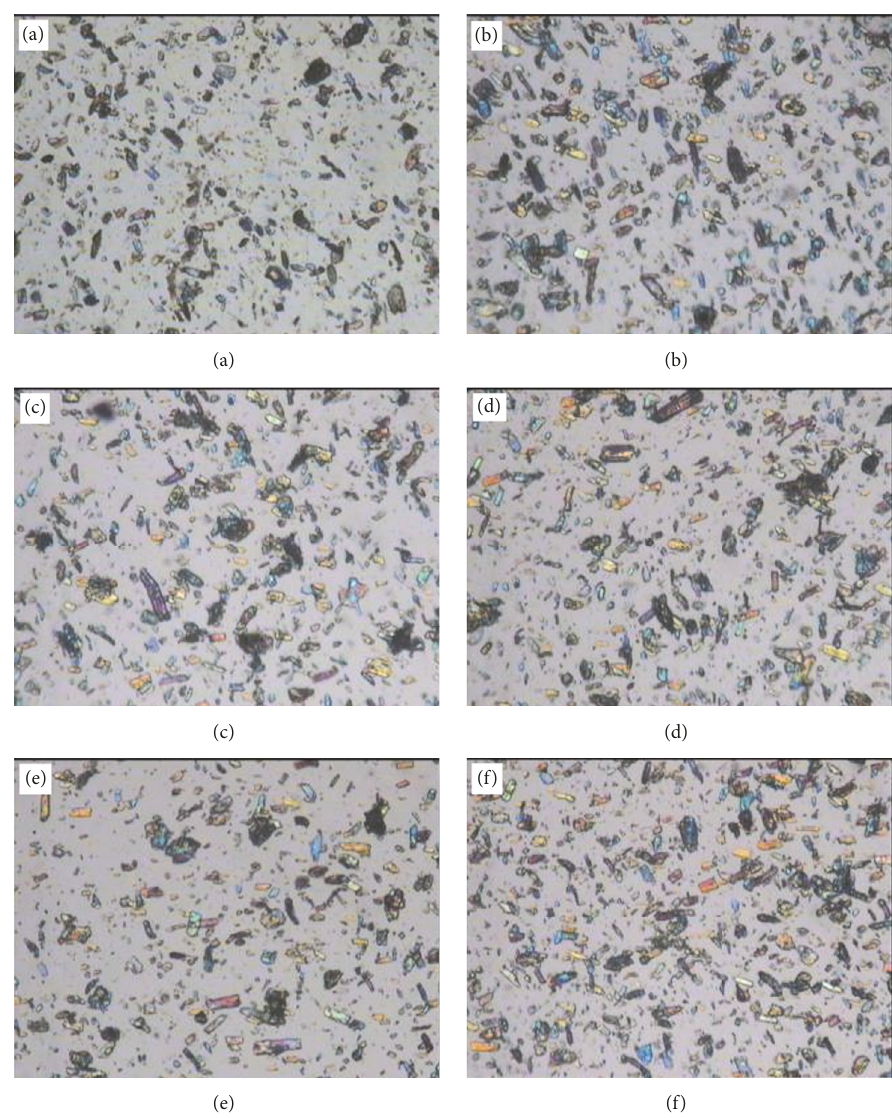
Figure 6: Polarized light photomicrographs showing the intensity and distribution of 5wt% MCC and NC particles within molten PP: (a) 0, (b) 0.05, (c) 0.1, (d) 0.5, (e) 1, and (f) 2 wt% NC [magnification =